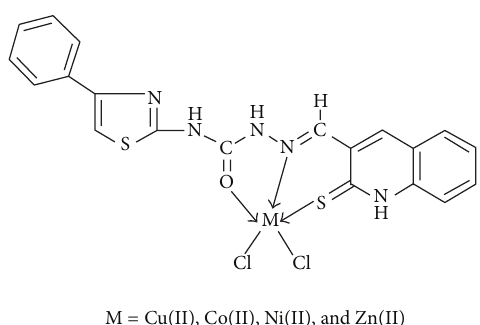
Figure 8: Proposed structure of the